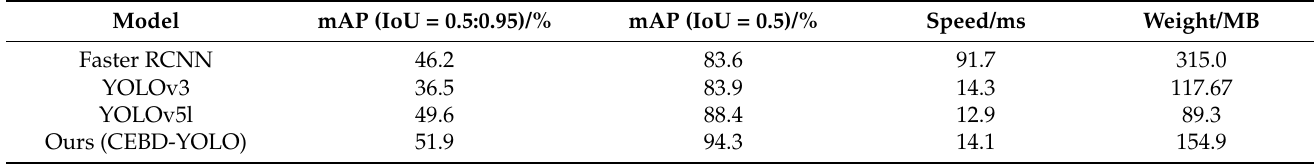
Table 4. Cow mounting behavior detection results obtained using different